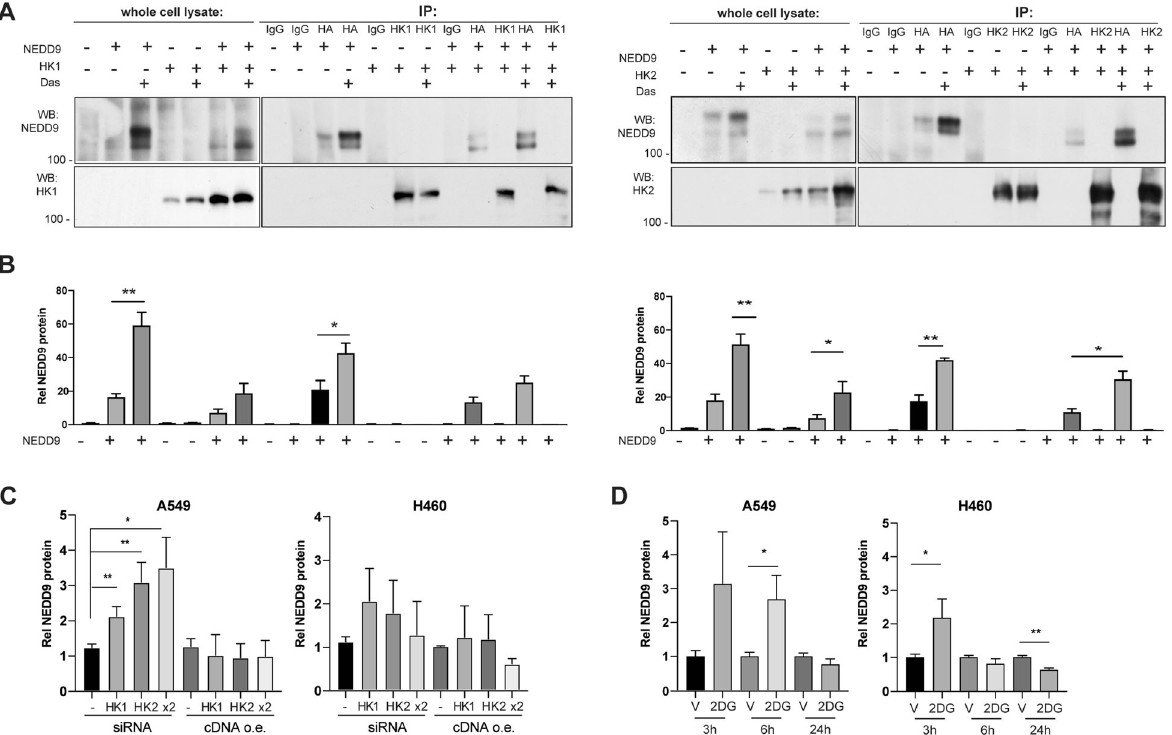
Fig. 4 Hexokinase depletion and 2DG treatment induce NEDD9 expression. A , B Western blot of whole cell lysates or immunoprecipitates of HEK293 cells overexpressing empty vectors (-), HA-NEDD9, or GFP-HK1 (HK1; left panel), or GFP-HK2 (HK2; right panel) as indicated. Shown, representative experiments ( A ), and quantitation of results from multiple experiments ( B ). C Western blot analysis of NEDD9 expression in NSCLC cell lines with depletion (siRNA) or overexpression (o.e.) of control (-), HK1, HK2, or both (x2). D Western blot quanti fi cation of NEDD9 expression in cells treated with vehicle (V) or 2DG for times indicated. All quanti fi cation is based on at least three independent experiments, with data normalized to Ponceau staining. * p < 0.05, ** p < 0.01, for all graphs.